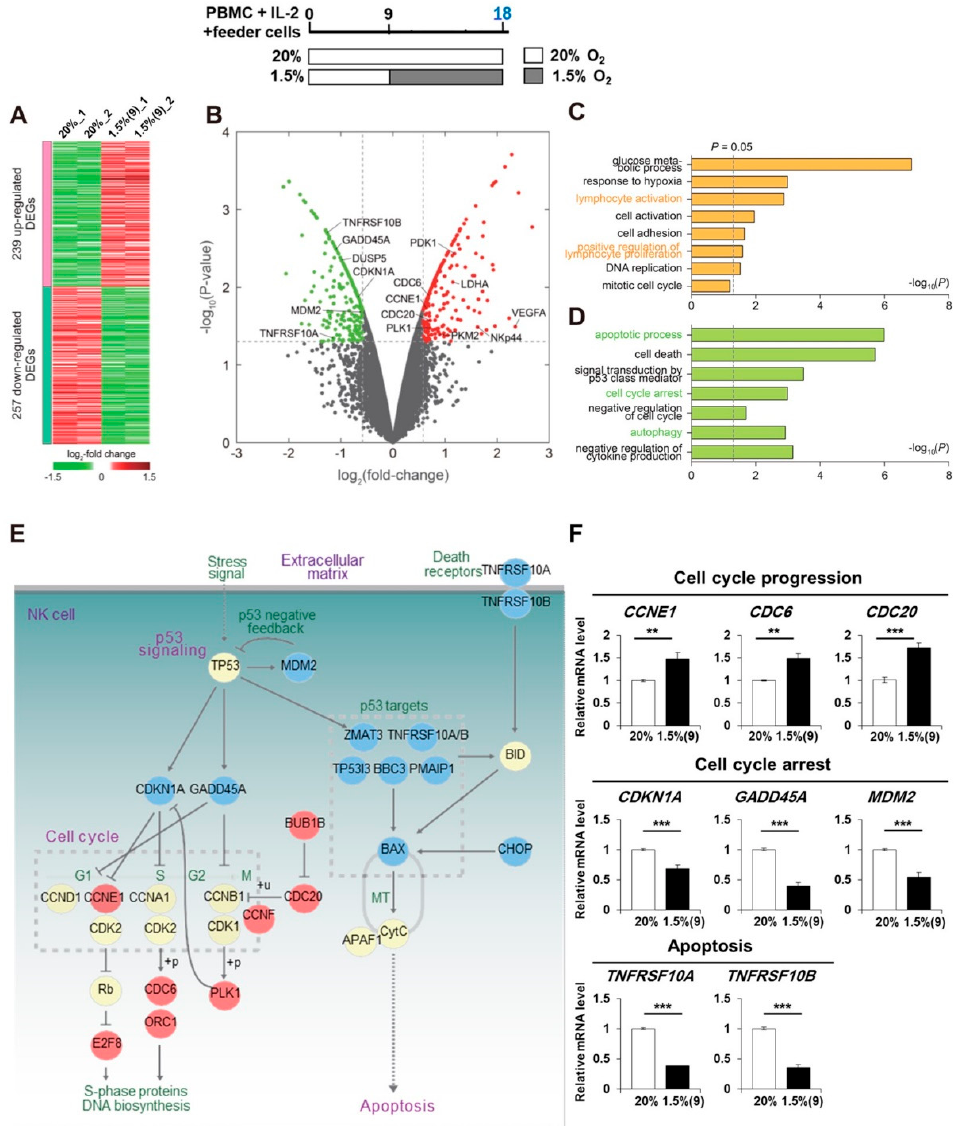
Figure 3 . Pre ‐ activated hypoxic NK cells upregulate cell cycle and downregulate cell ‐ cycle arrest and apoptosis. ( A ) Heat map shows upregulated and downregulated genes in pre ‐ activated hypoxic NK cells, compared to those in normoxic NK cells. RNA was isolated from purified NK cells in each condition, as described in Materials and Methods, for processing RNA ‐ seq. RNA ‐ seq analyses were performed using the two samples from two donors. Red and green represent upregulated and downregulated genes, respectively. ( B ) Volcano plot showing more differentially expressed genes in the pre ‐ activated hypoxic NK cells than in the normoxic NK cells. Red and green dots represent upregulated and downregulated genes, respectively, and gray dots represent genes whose expression was not significantly different. ( C , D ) GOBPs enriched by the upregulated ( C ) and downregulated ( D ) genes. Enrichment significance is displayed as –log 10 (P), where P is the enrichment p ‐ value for the corresponding GOBP. ( E ) The network model, describing the interplays among the upregulated or downregulated genes involved in cell cycle arrest, progression, and apoptosis (Kyoto Encyclopedia of Genes and Genomes pathway database). Node colors represent upregulation (red), downregulation (blue), and no change (yellow) of the corresponding genes in the pre ‐ activated hypoxic NK cells, compared to that in normoxic NK cells. Solid and dotted lines denote direct and indirect interactions, respectively. ( F ) Relative mRNA levels of the denoted genes in normoxic and pre ‐ activated hypoxic NK cells at day 23 were analyzed by quantitative RT ‐ PCR. NK cells in PBMCs were expanded with IL ‐ 2 and feeder cells under normoxic or hypoxic conditions and then isolated. mRNA level of each gene was normalized using the 18S rRNA level. Data obtained from more than two independent experiments, each using PBMCs from different individual donors, are presented as the mean ± SEM. **, p < 0.01; ***, p < 0.001 by Student’s two ‐ tailed t ‐ test.